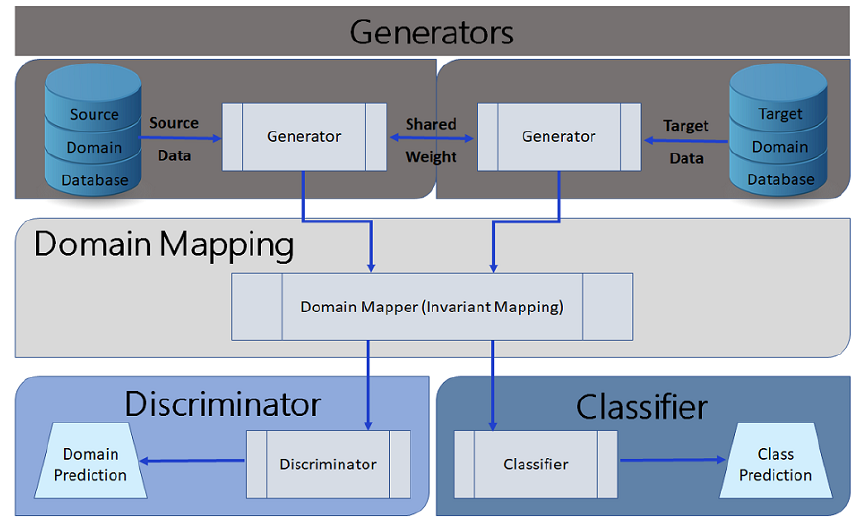
Figure 4. GAN-based Domain Adaptation (Recreated with permission from ref. [30]. Copyright 2022 Ankush